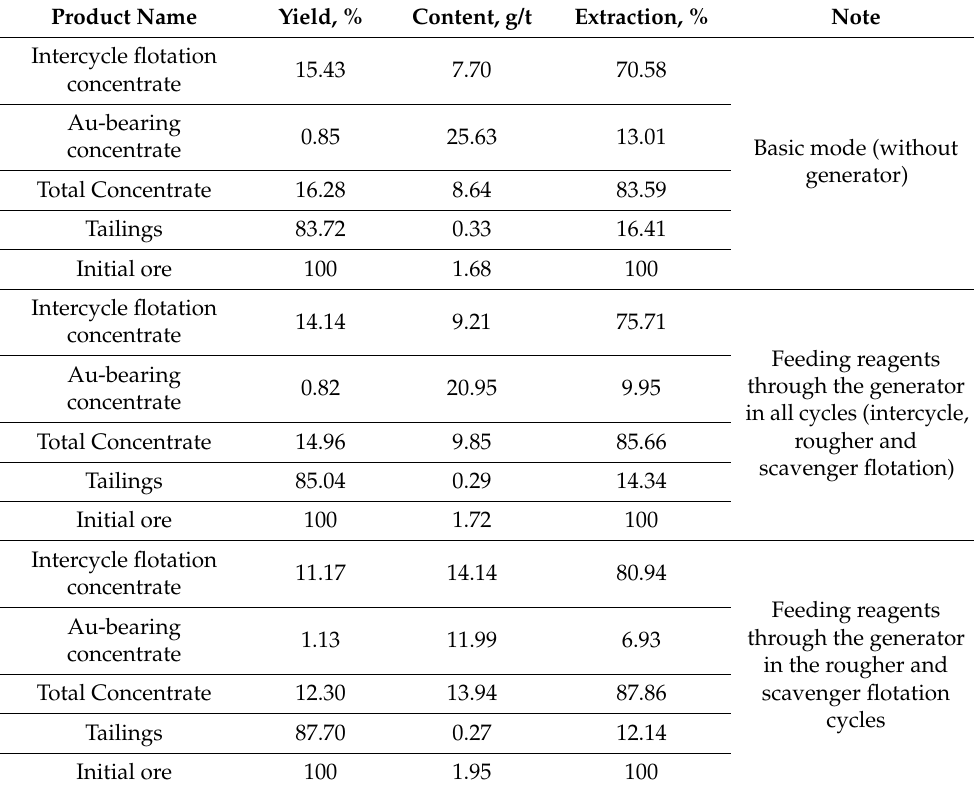
Table 8. Results of laboratory experiments in basic mode without and with a